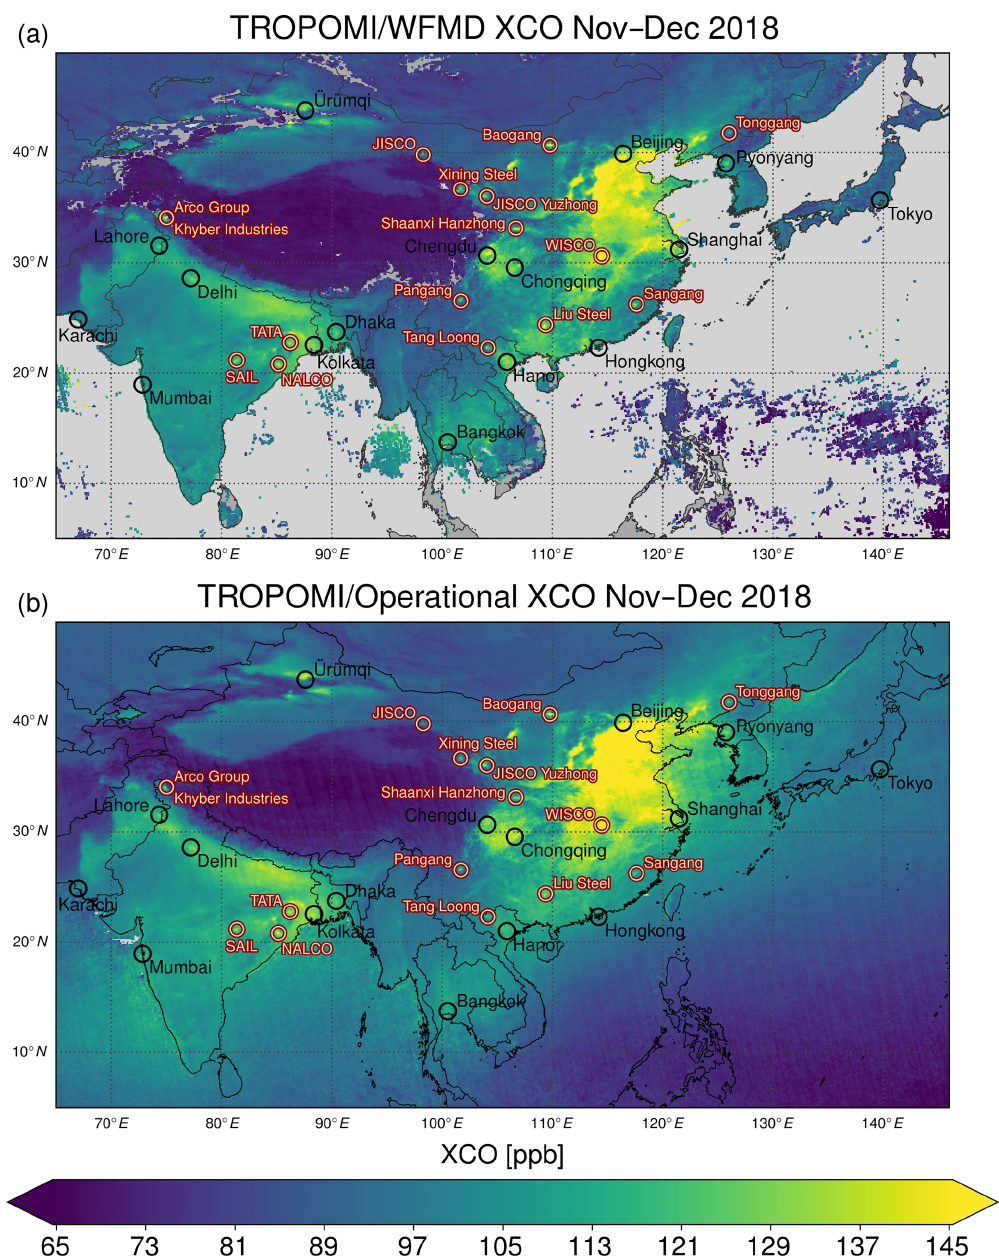
Figure 18. Carbon monoxide distribution for November and December 2018 over China, India, and Southeast Asia highlighting emissions from congested urban areas and industrial facilities. Panel (a) shows the TROPOMI/WFMD product and panel (b) the operational